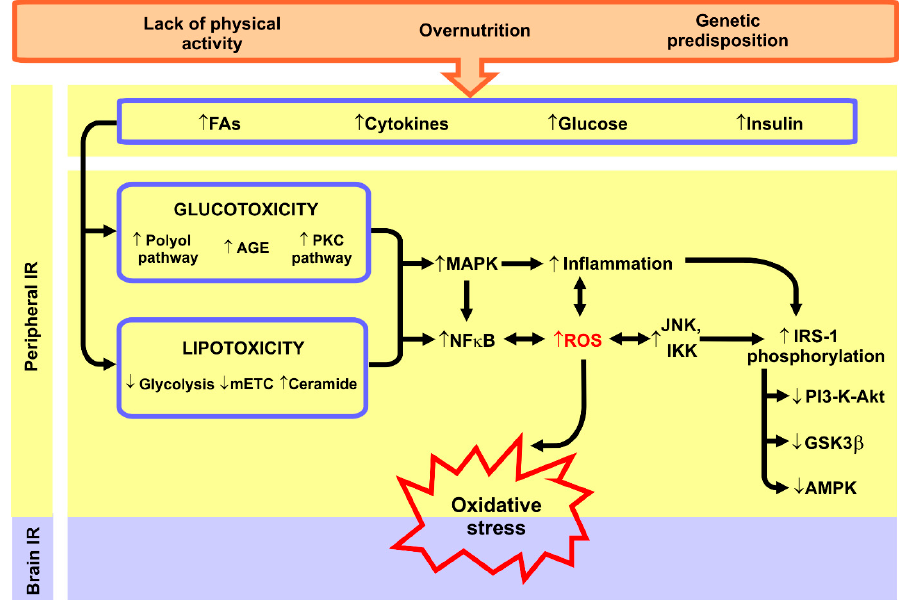
Figure 2. Metabolic disturbances in peripheral insulin resistance as a source of brain oxidative stress . Under insulin resistance (IR) conditions, enhanced plasma fatty acids (FAs), hyperglycaemia, and hyperinsulinemia promote glucotoxicity and lipotoxicity (especially ceramide accumulation) leading to the activation of nuclear factor κ B (NF κ B) and pro-inflammatory signalling (e.g., MAP-kinases). Not only does it intensify the inflammation, but it also increases the formation of reactive oxygen species (ROS). Abbreviations: AGE, advanced glycation end products; AMPK, AMP-activated protein kinase; FAs, fatty acids; GSK3 β , glycogen synthase kinase 3 beta; IKK, I κ B kinase; IRS-1, insulin receptor substrate 1; IR, insulin resistance; JNK, c-Jun terminal kinase; MAPK, mitogen-activated protein kinases; mETC, mitochondrial electron transport chain; NF κ B, nuclear factor κ B; PKC, protein kinase C; PI3-K-Akt, phosphatidylinositol 3-kinase/Akt; ROS, reactive oxygen species.